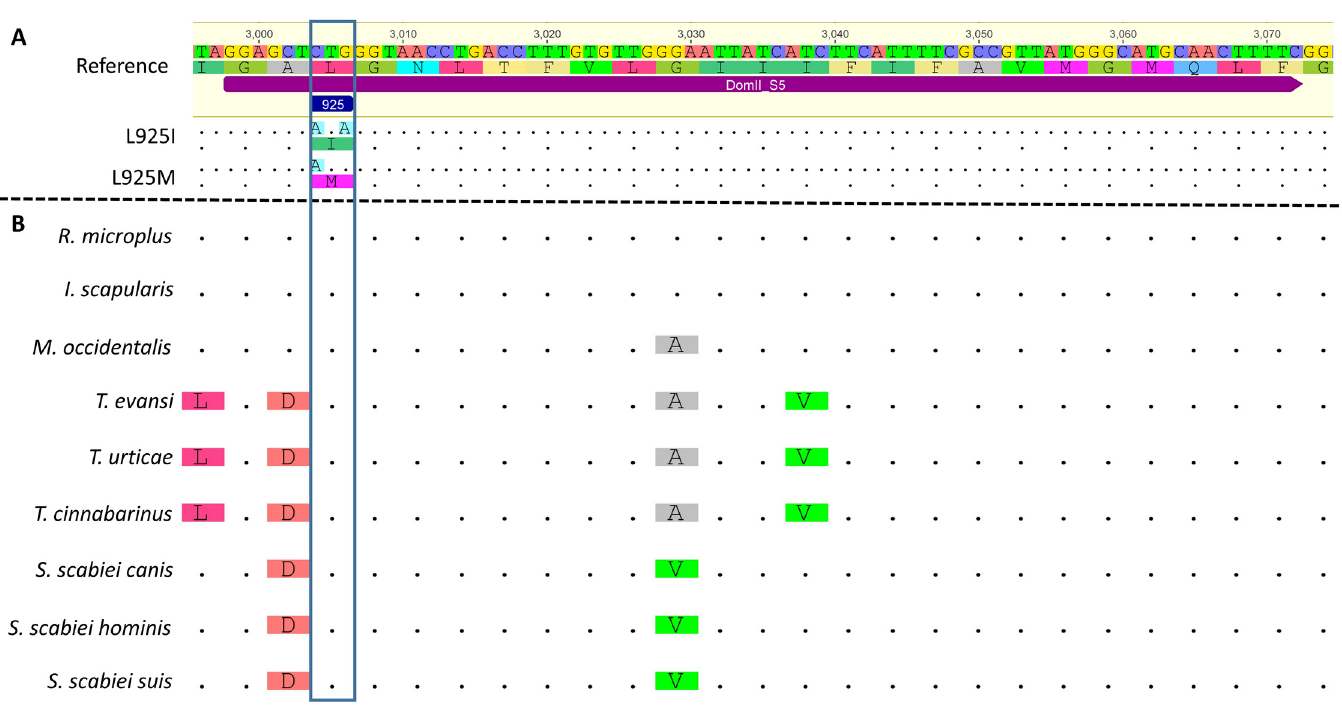
Fig 2. Alignment of nucleotide and/or amino acid sequences of the Voltage-Gated Sodium Channel fifth transmembrane segment (VGSC_IIS5). A- V . destructor reference (Accession KF771990) and mutated sequences. B- Rhipicephalus microplus (Accession Q9XZC1), Ixodes scapularis